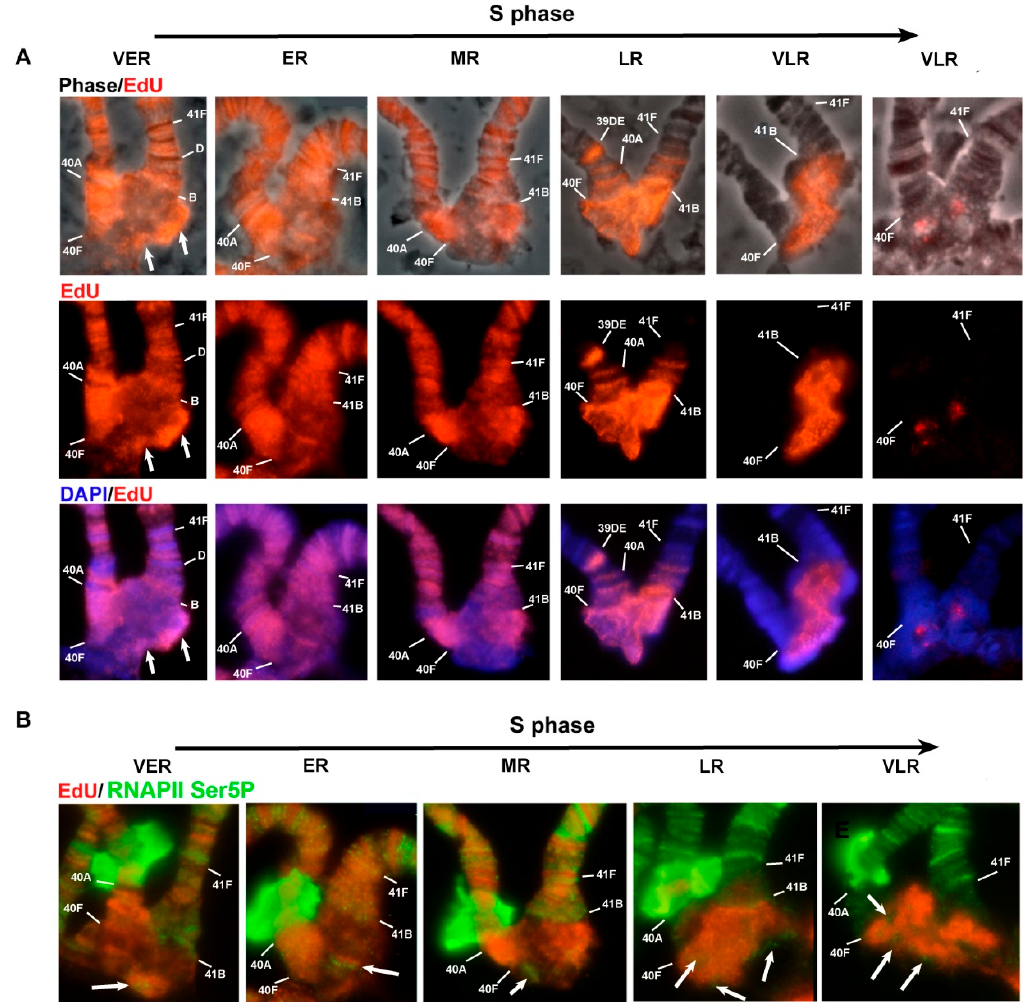
Figure 12. Replication patterns in the pericentromeric region of chromosome 2 and their relationship with the distribution of active transcription. ( A ) EdU incorporation into polytene chromosomes of Rif1 1 / Rif2 2 mutants at successive stages of the S phase. The upper row: a superposition of EdU and a phase contrast image, the middle row: EdU data and the bottom row: EdU (red) and DAPI (blue). ( B ) Simultaneous detection of EdU (red) and antibodies to RNAPII Ser5P (green).